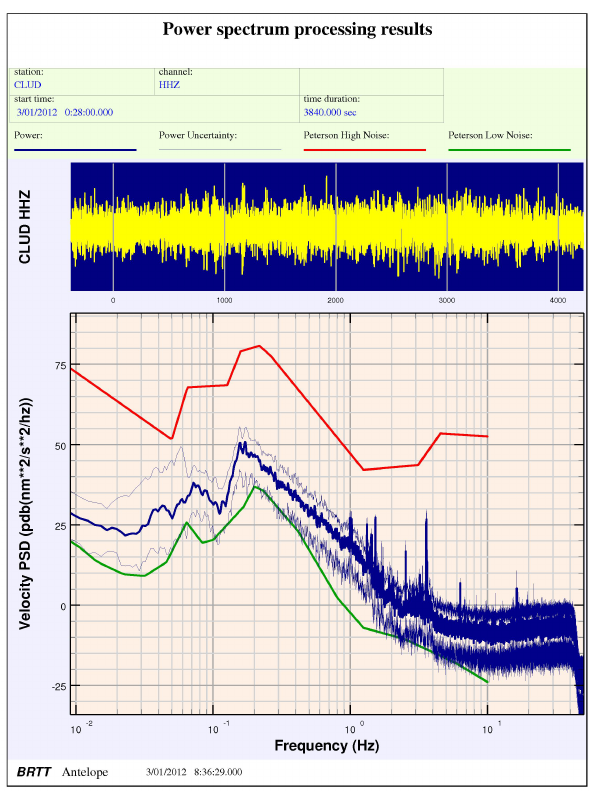
Fig. 5. PSD of seismic noise at CLUD